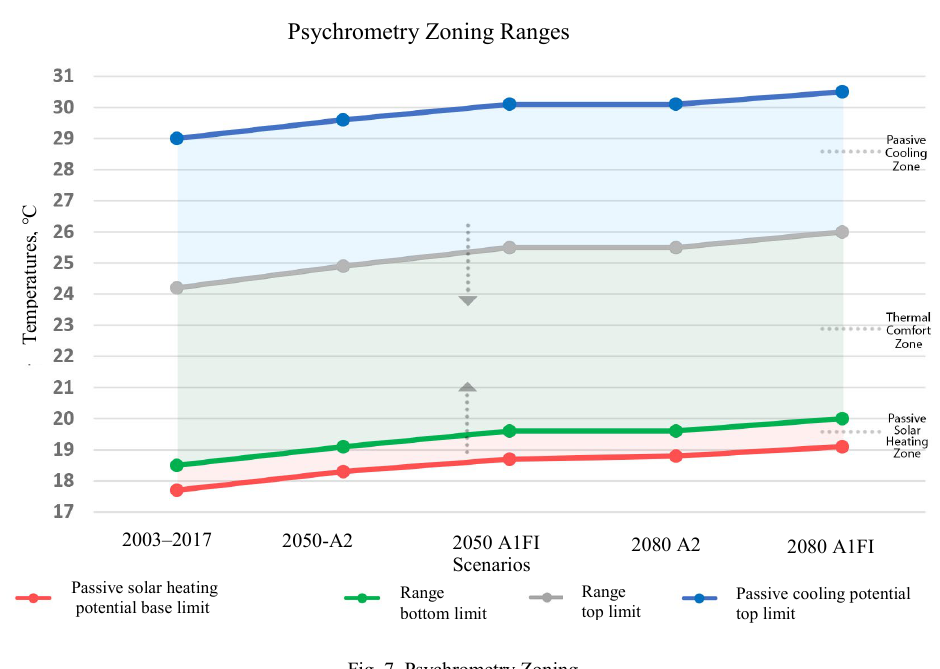
Fig. 7. Psychrometry